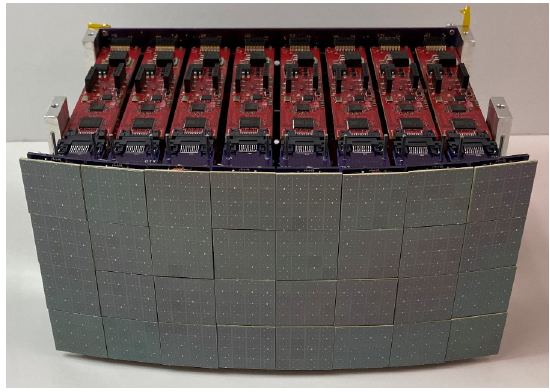
Figure 6: The 512 SiPM camera of the